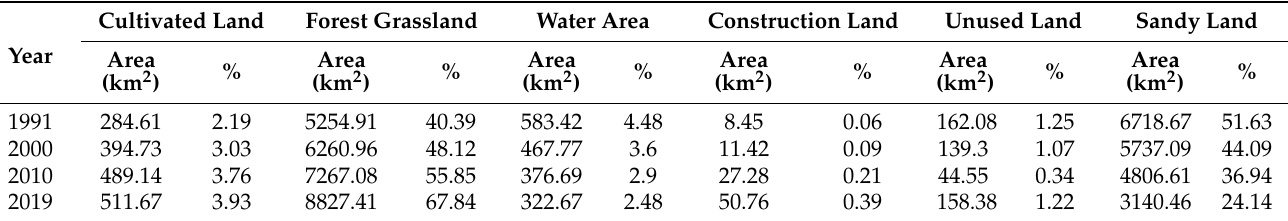
Table 4. The area of land-use change in various periods along the Yellow River section of the Hobq